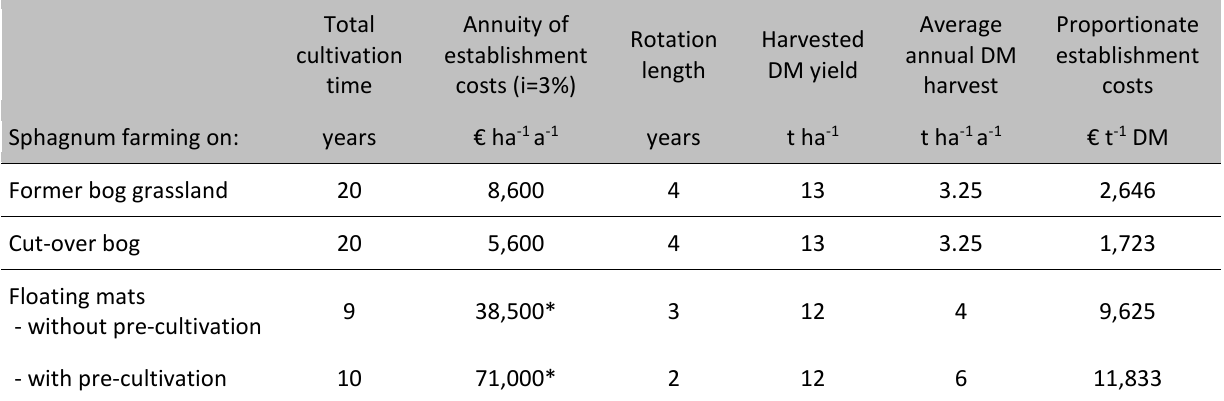
Table 6. Relation of the establishment costs to the harvested dry mass (DM) yield. Total cultivation